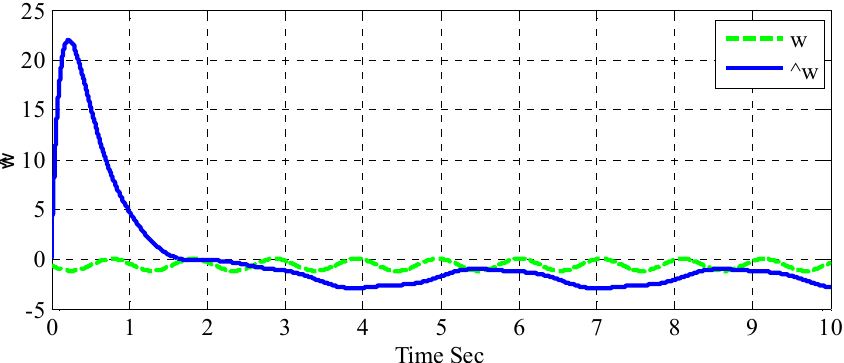
Figure 9. Adaptive backstepping disturbance estimator response with exerted disturbance.